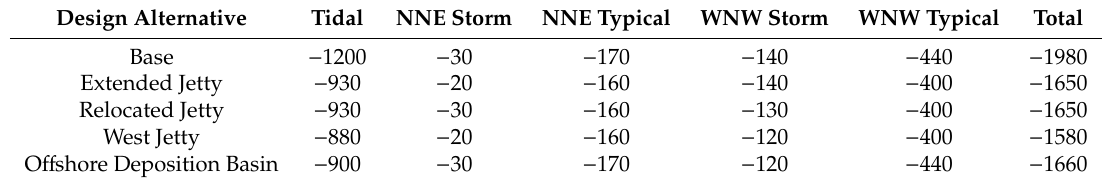
Table 9. Annualized cut volume estimate within channel limits (m 3 ).